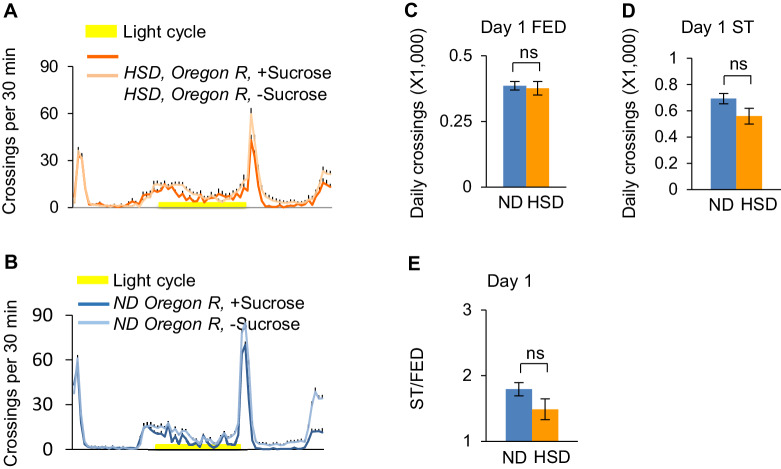
Dietary sugar does not affect starvation-induced hyperactivity.Wild-type Oregon-R virgin female flies fed with ND (blue) or HSD (orange) were assayed in the presence (dark color) and absence (light color) of 5% sucrose using DAMS-based locomotion assay (n = 41–63). Midline crossing activities of indicated flies are shown in A-B. (C–D) Average daily midline crossing activity of fed flies (C) and starved flies (D) assayed in A-B. (E) Starvation-induced hyperactivity of flies assayed in A-B. ns, p>0.05; *p<0.05; **p<0.01; ****p<0.0001. Student’s t-test and one-way ANOVA followed by post hoc test with Bonferroni correction were used for pair-wise and multiple comparisons, respectively.